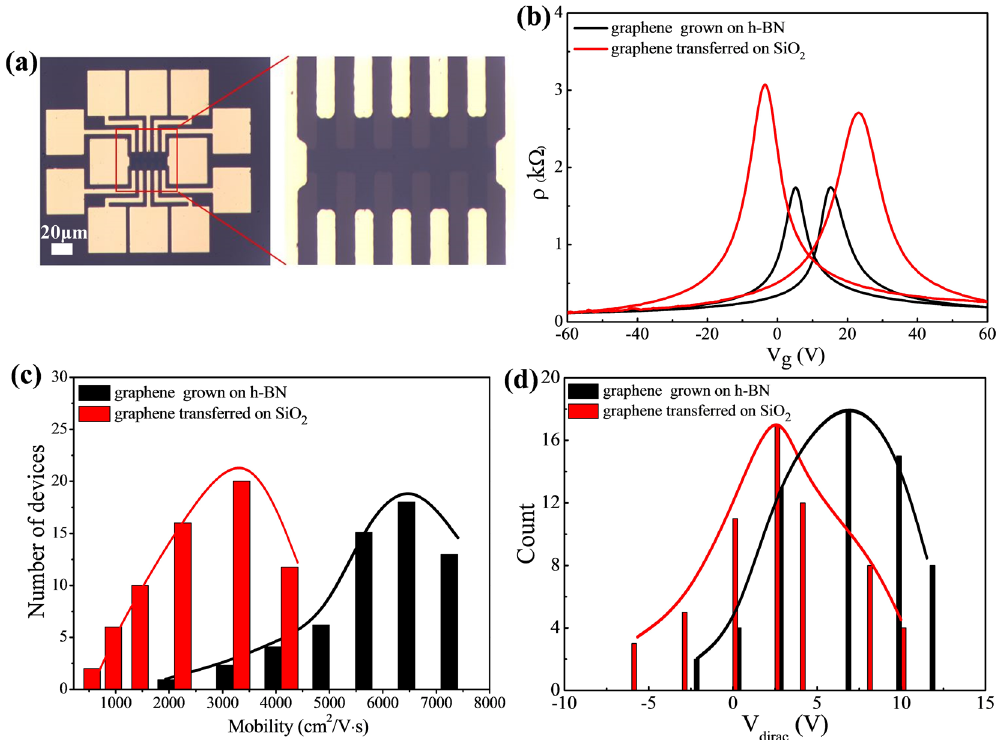
Figure 8. Electrical transport properties of graphene on h-BN. ( a ) Optical microscopic images of the device. ( b ) The longitudinal resistance R vs . the applied gate voltage V gate , including the graphene grown on h-BN and graphene transferred on SiO 2 . ( c ) Histogram of the carrier mobility distribution of graphene grown on h-BN and graphene transferred on SiO 2 . ( d ) Histogram of the average Dirac point of graphene grown on h-BN and graphene transferred on SiO 2